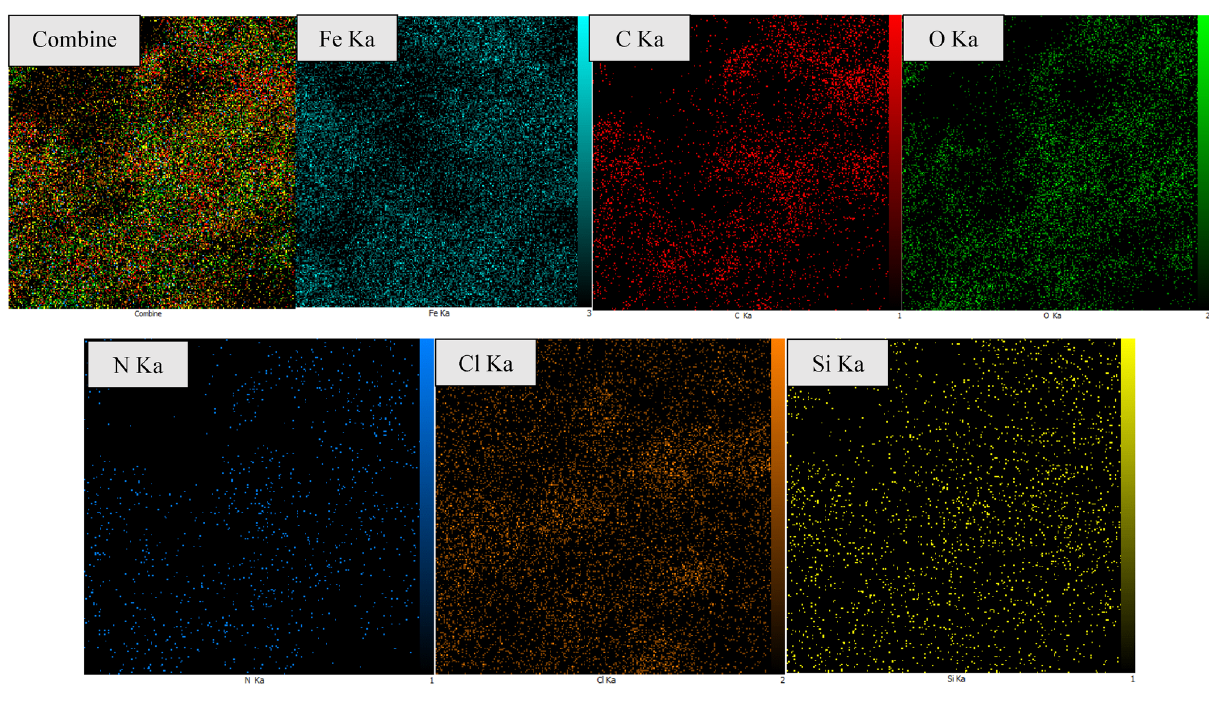
Figure 8. Maps of